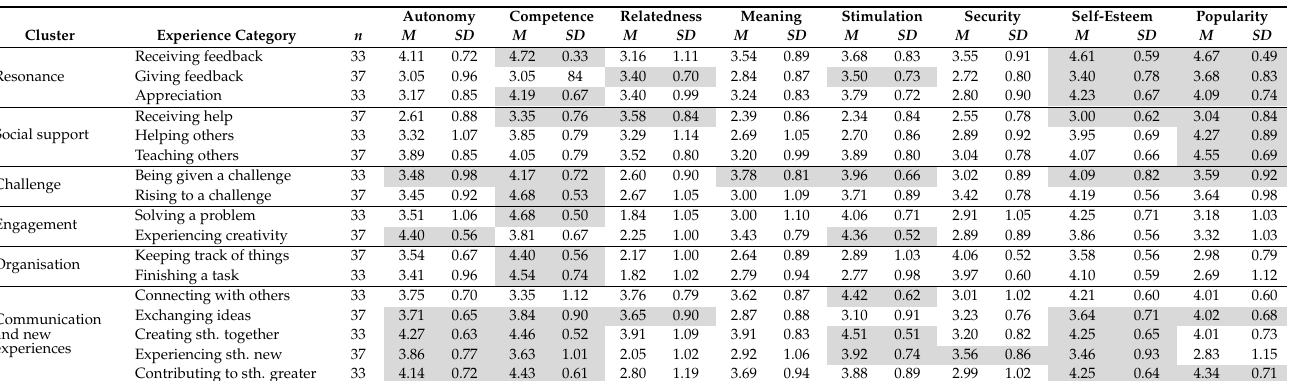
Table 6. Descriptive statistics (arithmetic means and standard deviations) of the needs scales on the 17 experience